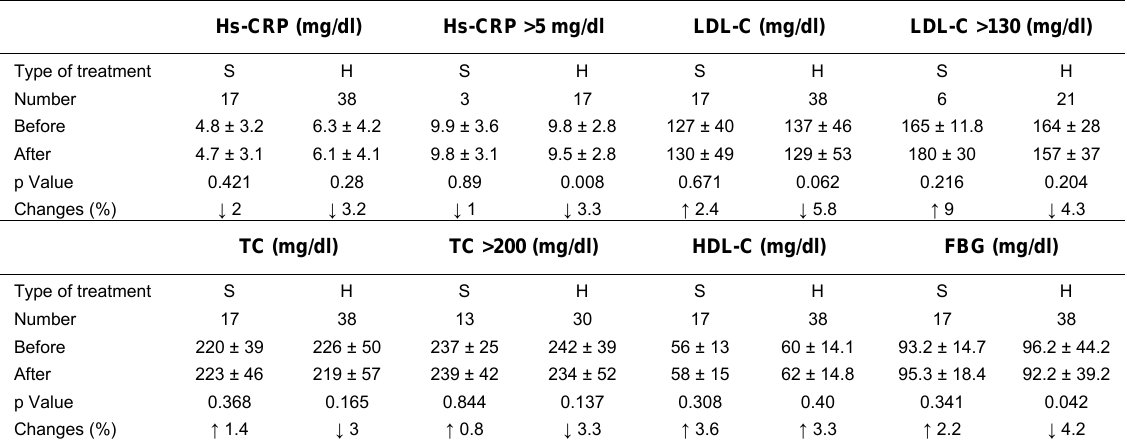
Effects of Sucrose and Honey on Biochemical